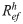
Estimation of Model FD in Period 1 (October/1995—September/2000).(a) observed incidence (O) and adjusted i (E), (b) m3/m, (c) Refh (h) and Refm (m), and (d) Ref=Refh×Refm.